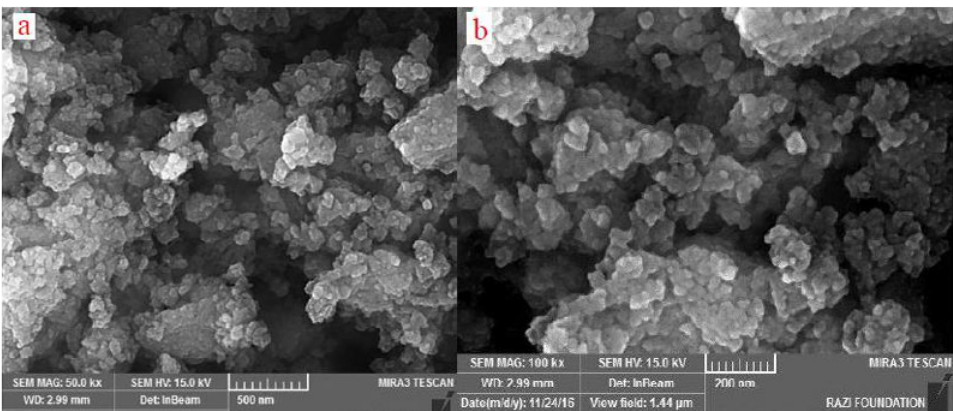
Fig. 2. (a) FE-SEM image of nano-colloidal silica @APTPOSS (b) SEM image of nanocatalyst after six times reuse